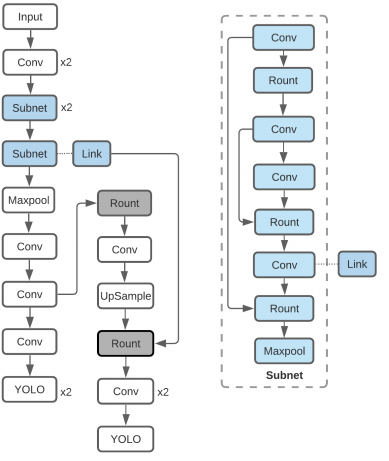
Figure 3. YOLO v4 used for object